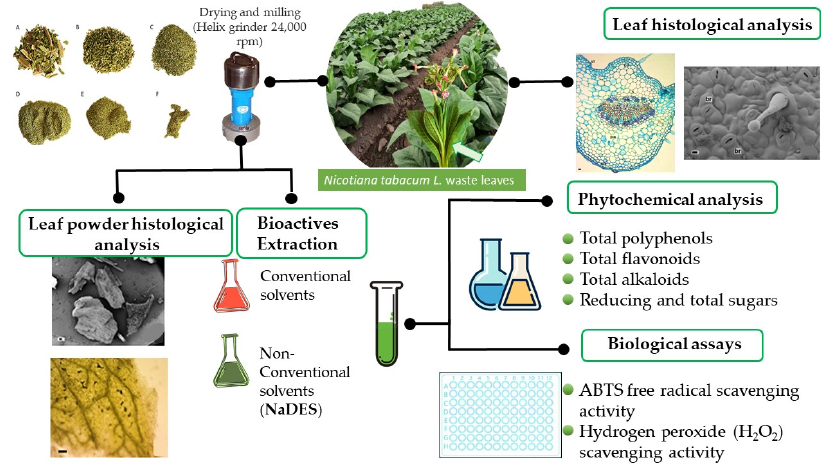
Figure 2. Flowchart illustrating the process of tobacco leaf waste under study. Molecules 2023 , 28 , x FOR PEER